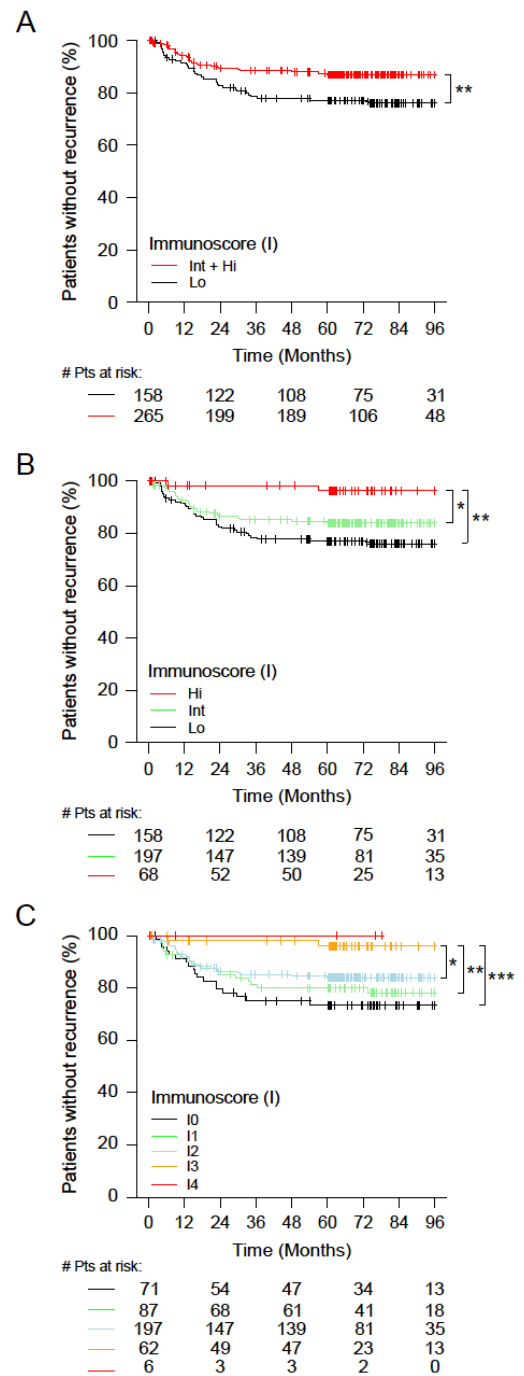
Figure 2. The outcomes of stage I–III colon cancer patients according to Immunoscore. ( A – C ) Kaplan–Meier curves of Immunoscore for stage I–III patients are shown for time to recurrence (TTR). ( A ) Two Immunoscore categories: Lo (0–25%, black) and Int+Hi (>25–100%, red). ( B ) Three Immunoscore categories: Lo (0–25%, black), Int (>25–70%, green), and Hi (>70–100%, red). ( C ) Five Immunoscore categories: I0 (0–10%, black), I1 (>10–25%, green), I2 (>25–70%, azure), I3 (>70–95%, orange), and I4 (>95–100%, red). Significant log-rank p -values are marked as *** p < 0.005, ** 0.005 ≥ p < 0.01, and * 0.01 ≥ p < 0.05.